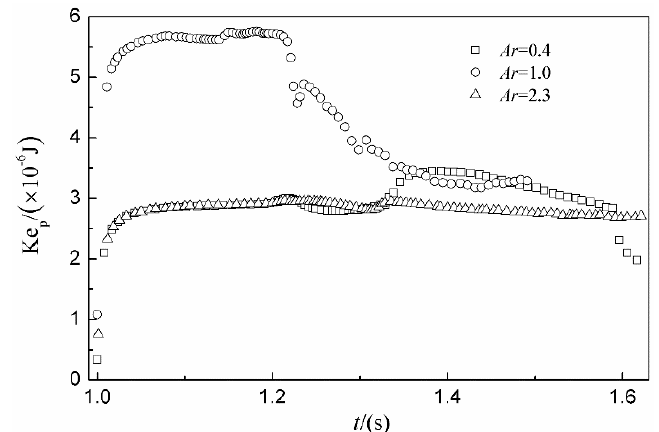
Figure 16. Effects of Ar on particle turbulent kinetic energy.